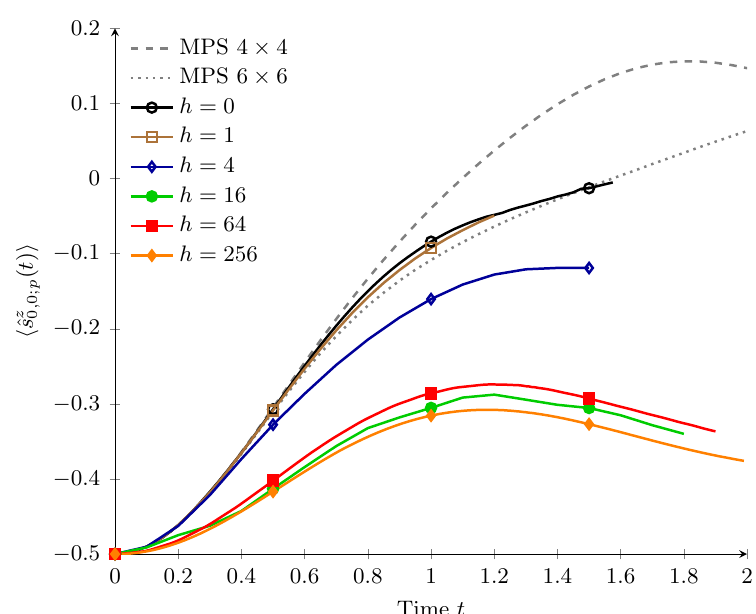
( t ) 〉 at various disorder strengths. A noticeable Figure 4: Expectation value of 〈 ˆ s z 0,0; p slow-down of dynamics is observed at increased disorder strengths h ≥ 16; MPS calculations at h = 0 show finite-size effects at t <